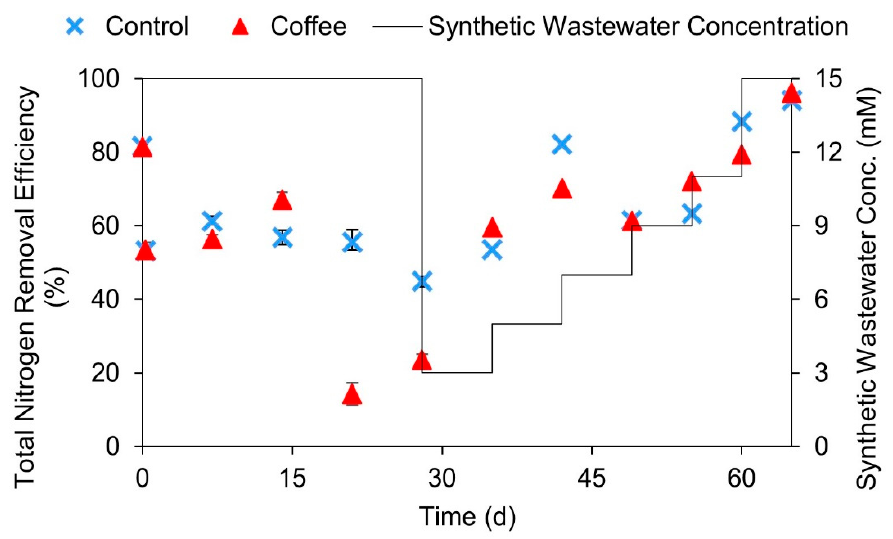
Figure 9. Percentage of total nitrogen removal and synthetic wastewater concentration during long-term coffee dosing.